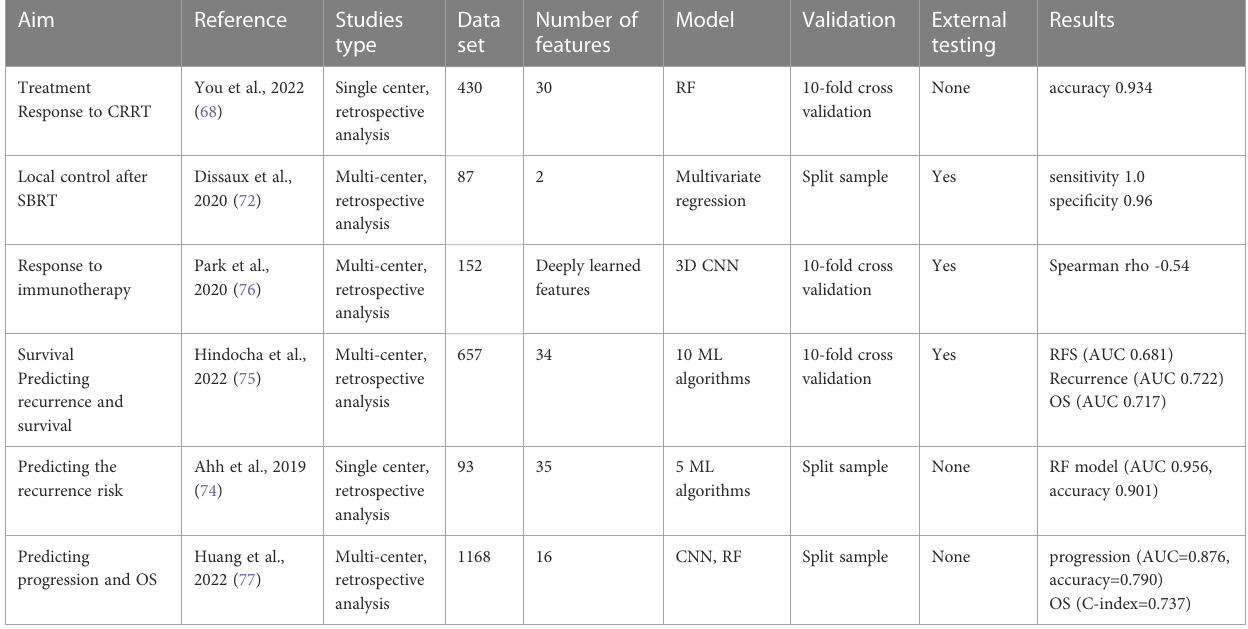
TABLE 4 Main fi ndings on treatment outcome and